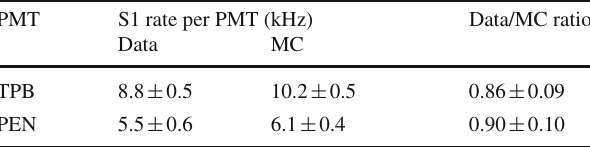
Table7 AverageS1rateperPMTinrandom-triggermodeanddata/MC ratio. The error of the S1 rate corresponds to the STD among PMTs PMT S1 rate per PMT (kHz) Data/MC ratio Data